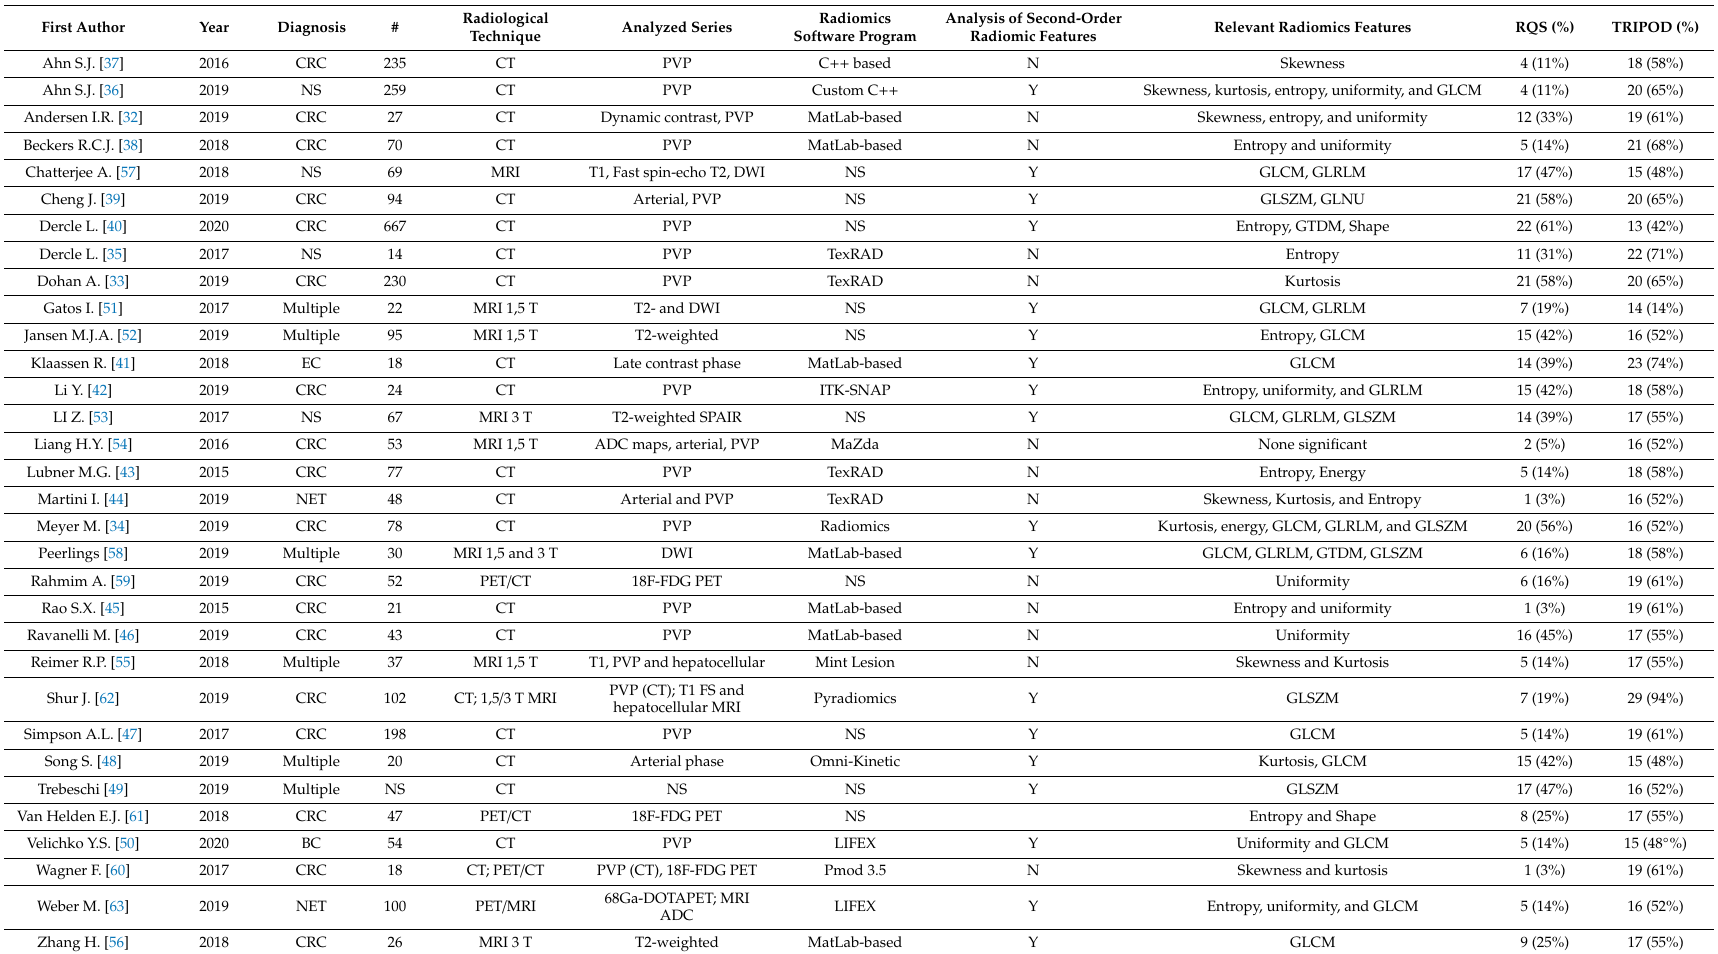
CRC: Colorectal Cancer, NET: Neuroendocrine Tumor, EC: esophageal cancer, BC: breast cancer, PVP: portal venous phase, FS: fat suppression, DWI: di ff usion-weighted images, SPAIR: spectral-attenuated inversion recovery, ADC: apparent di ff usion coe ffi cient, GLCM: gray level co-occurrence matrix, GLRLM: gray-level run-length matrix, GTDM: gray-tone di ff erence matrix, GLSZM: gray level size zone matrix, GLNU: gray-level non-uniformity, NS: not